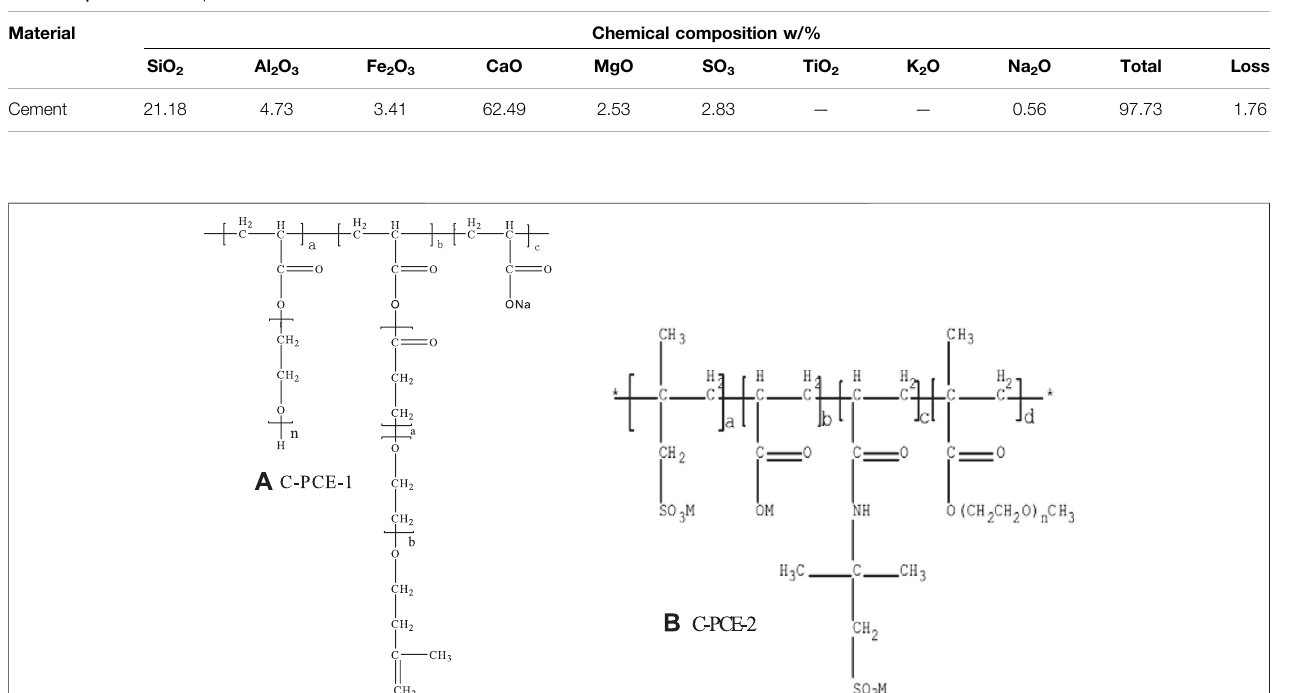
TABLE 1 | Chemical composition of PI 42.5 Portland cement w/%.